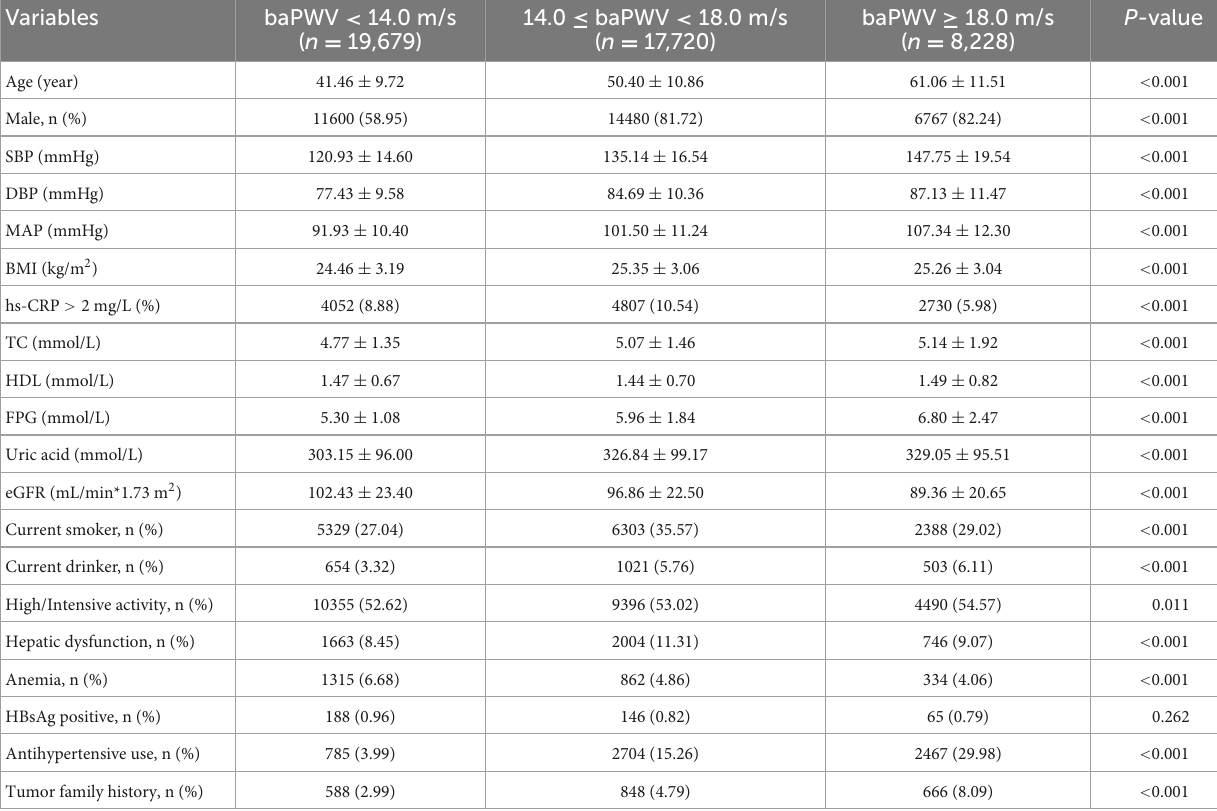
TABLE 1 Baseline clinical characteristics of